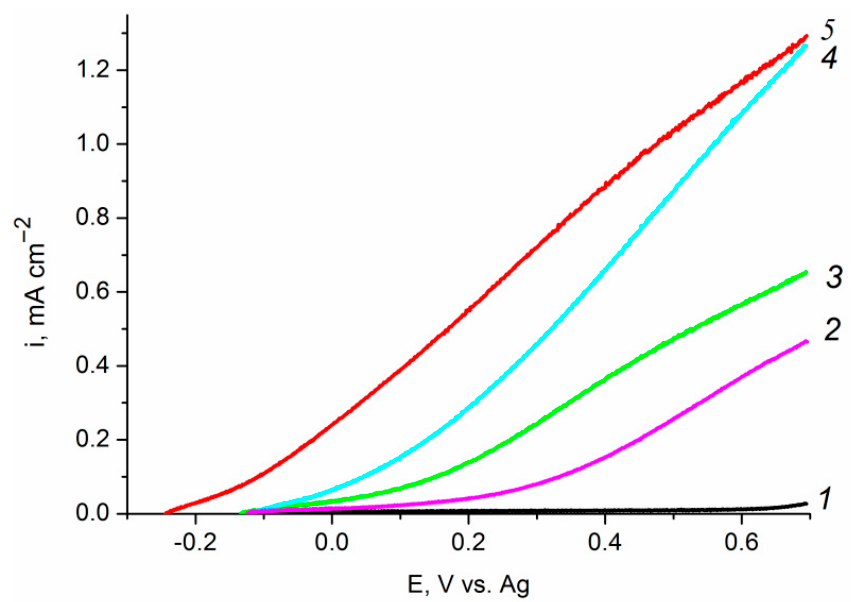
Figure 6. Polarization curves of a Ti 4+ /Fe 2 O 3 /FTO film photoanode measured: (1) in dark conditions, and (2–5) under visible light illumination with a power density of 100 mW cm − 2 in aqueous solutions of (2) 0.1 M KOH; (3) 0.1 M KOH + 20% CH 3 OH; (4) 0.1 M KOH + 20% C 2 H 4 (OH) 2 ; and (5) 0.1 M KOH + 20% C 3 H 5 (OH) 3 .